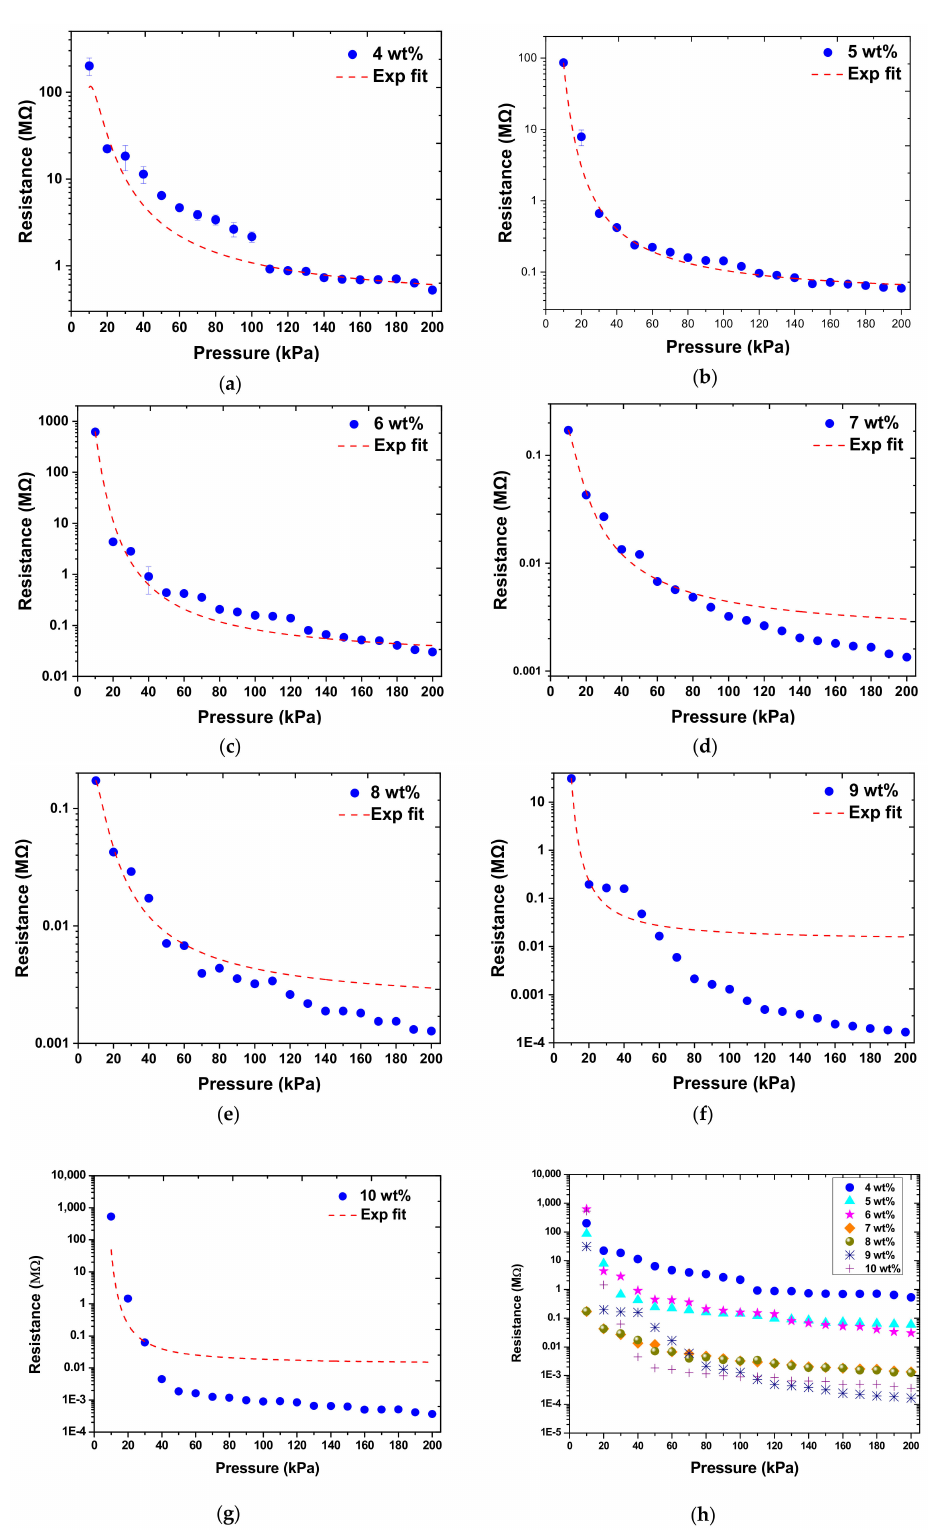
Figure 12. The resistance output as function of applied pressure for MWCNT doping ratios